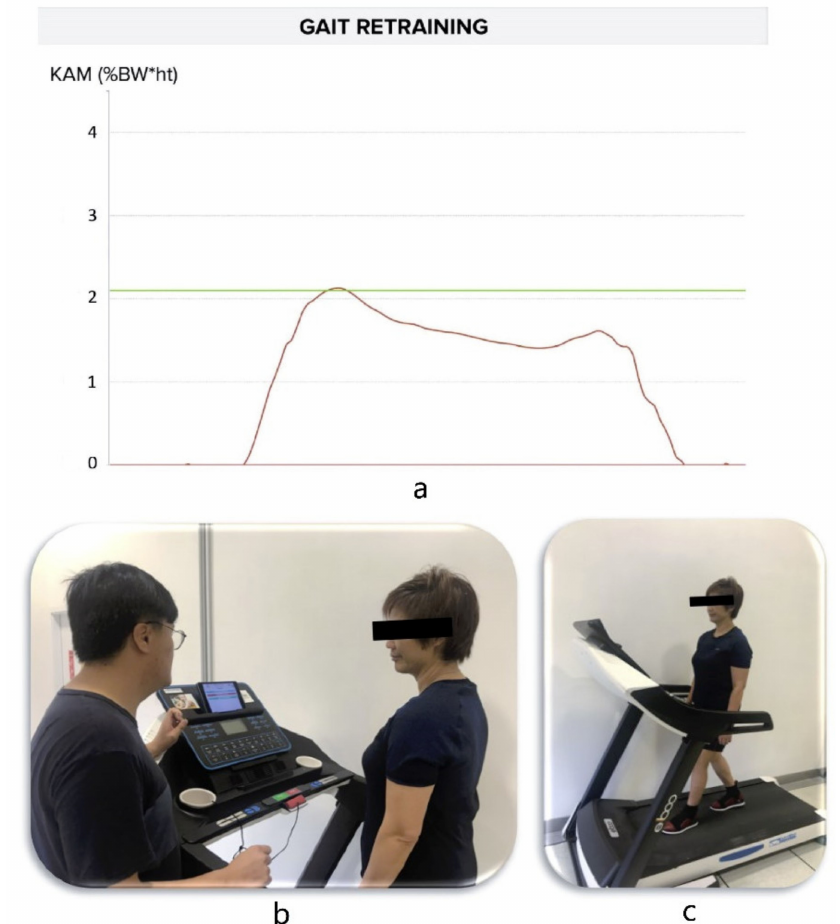
Figure 2. ( a ) Example of the real-time predicted KAM curve (red line) when the participant walked with modified gait on a treadmill. The green line indicates the target threshold of KAM; ( b ) Researcher was explaining the intervention to the participant; and ( c ) Participant was undergoing gait retraining with visual